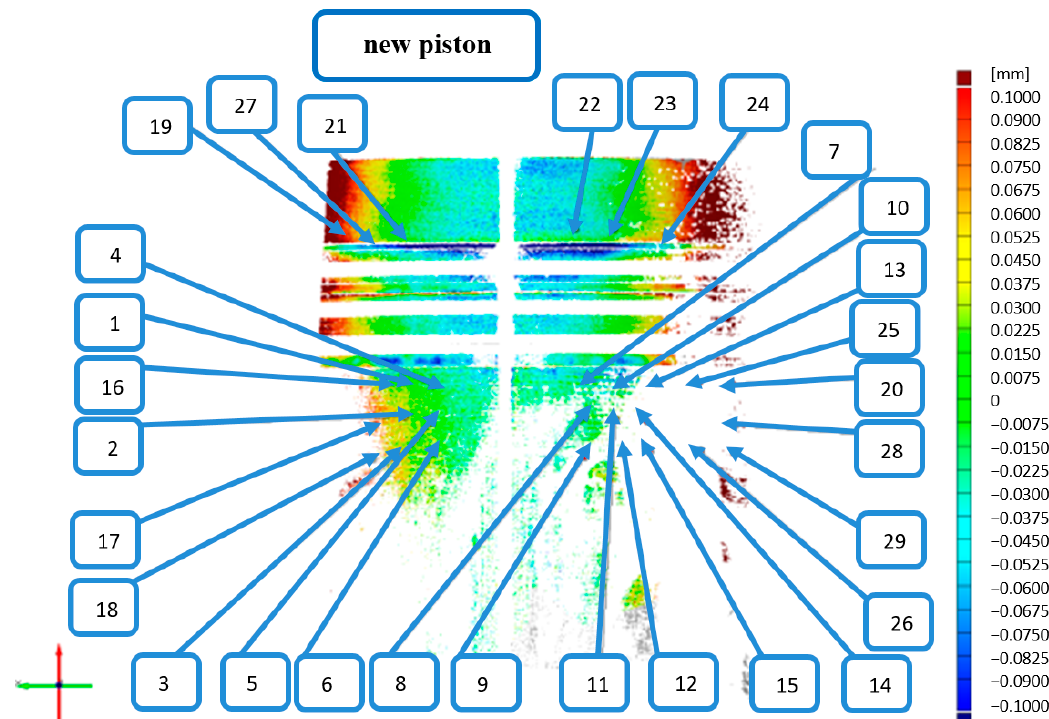
Energies 2021 , 14 , x FOR PEER REVIEW 12 of 17 Figure 11. Geometrical deformation of the new piston at a temperature of 250 °C (Table 2). Figure 11. Geometrical deformation of the new piston at a temperature of 250 ◦ C (Table 2).